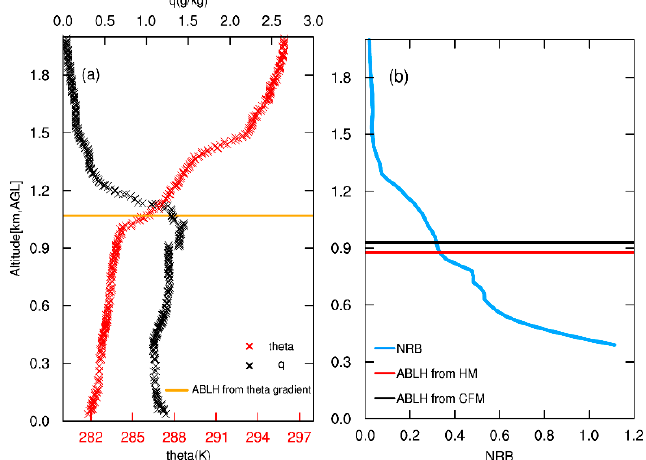
Figure 5. Vertical profiles of ( a ) potential temperature (theta) and specific humidity (q) at Yuzhong site, (b) lidar NRB at SACOL (Semi-Arid Climate observatory and Laboratory). The ABLH determined using different methods are marked in each panel. The profile was observed at 12:00 UTC on 17 January 2011 (In cloud-free condition).